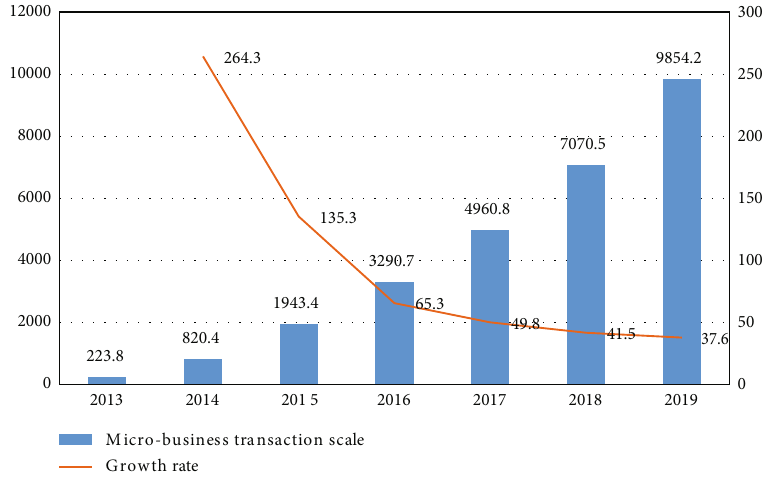
Figure 1: Changes in the market size of the microbusiness